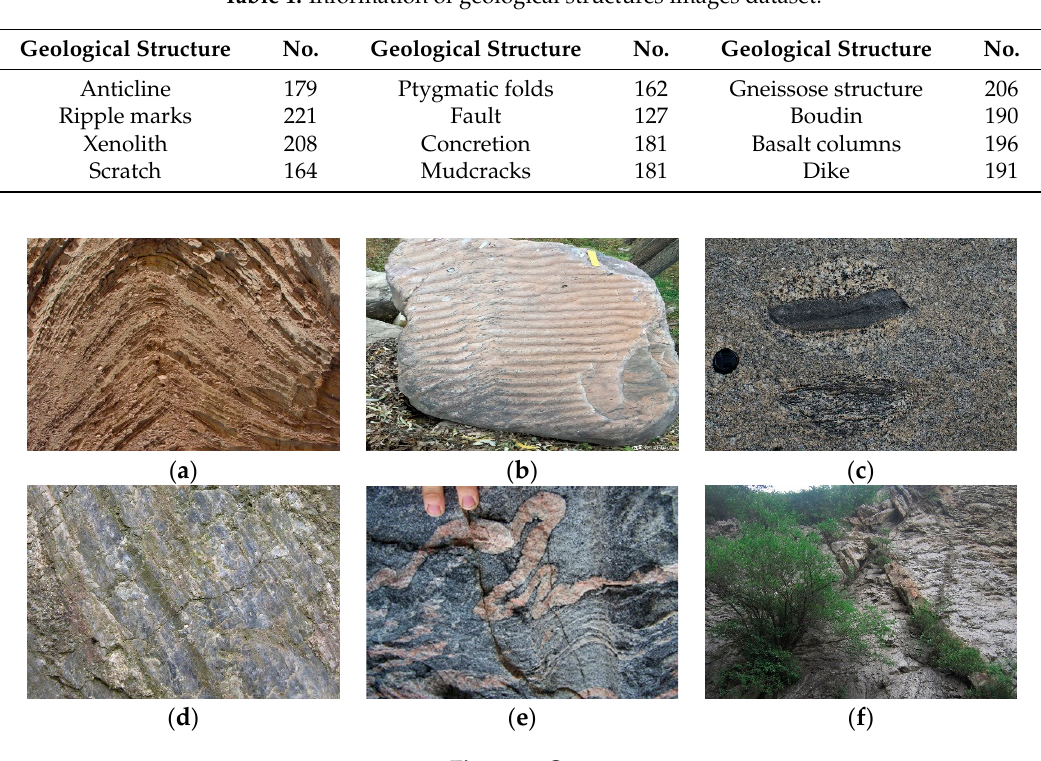
Table 1. Information of geological structures images dataset.